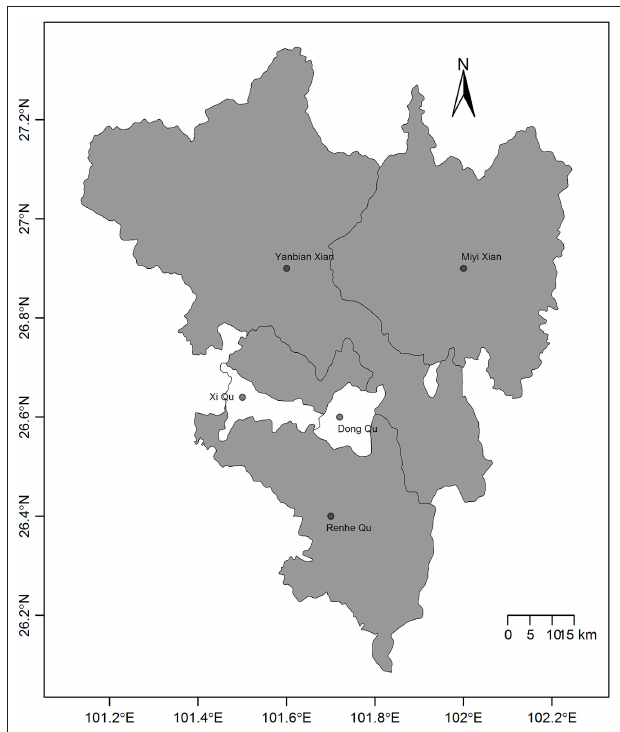
FIGURE 1 | Map of the 5 counties in Panzhihua, Southwest China. The gray counties have a high incidence of scrub typhus and are rural areas whereas the white counties have a low incidence of scrub typhus and are urban